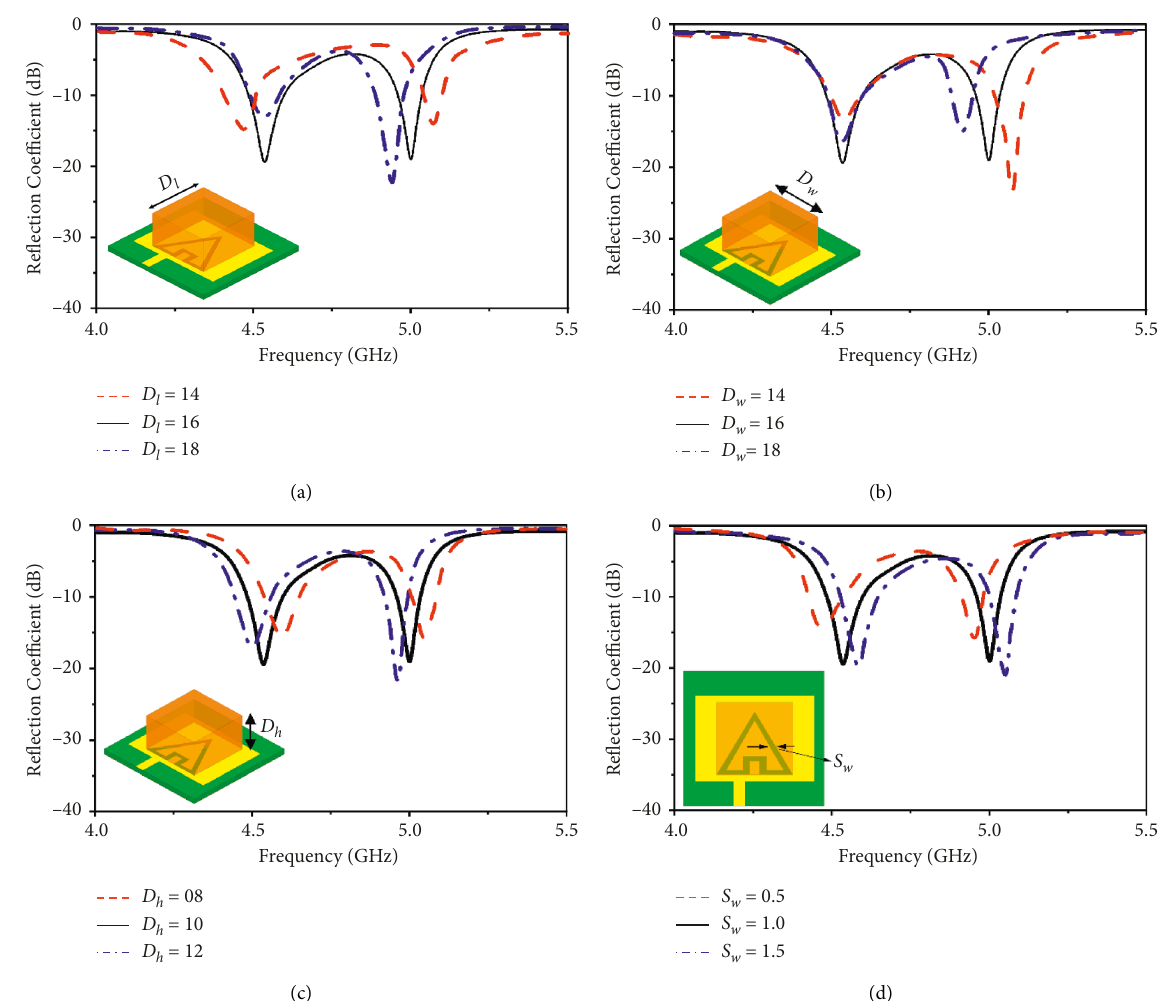
Figure 4: Parametric study of DRA. (a) length, (b) width, (c) height, (d) slot